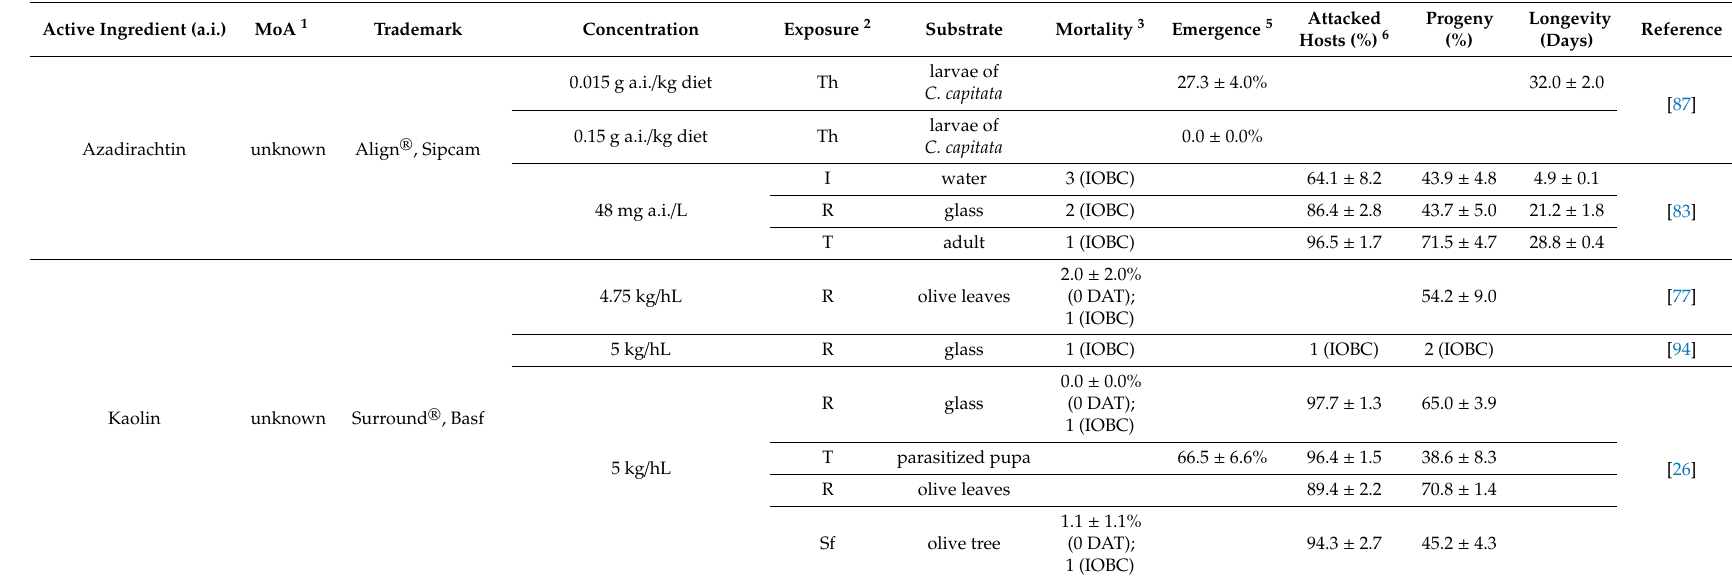
Active Ingredient